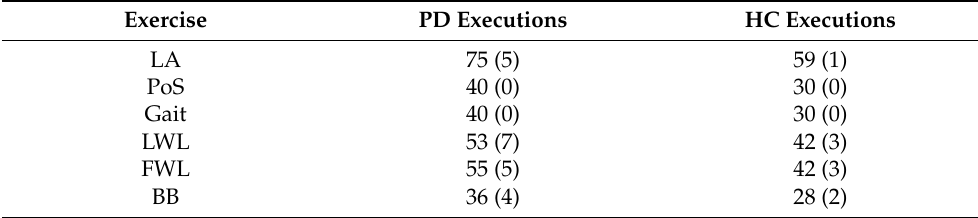
Table 2. Number of valid executions included in data analysis (in parenthesis, the number of discarded executions).